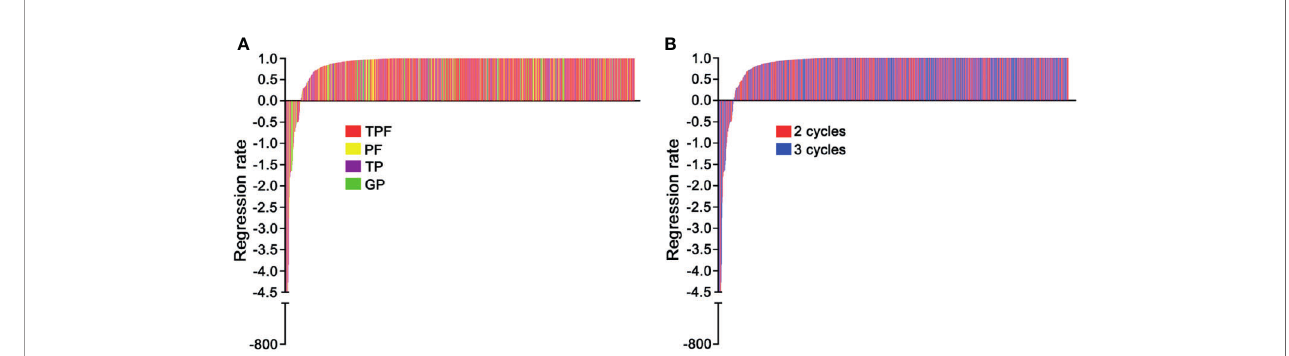
FIGURE 1 | (A) Waterfall plot of decrease rate for each patient between different induction chemotherapy regimens; TPF, docetaxel plus cisplatin/nedaplatin and 5- fl uorouracil; PF, cisplatin/nedaplatin plus 5- fl uorouracil; TP, docetaxel plus cisplatin/nedaplatin; GP, gemcitabine plus cisplatin; (B) Waterfall plot of decrease rate for each patient between